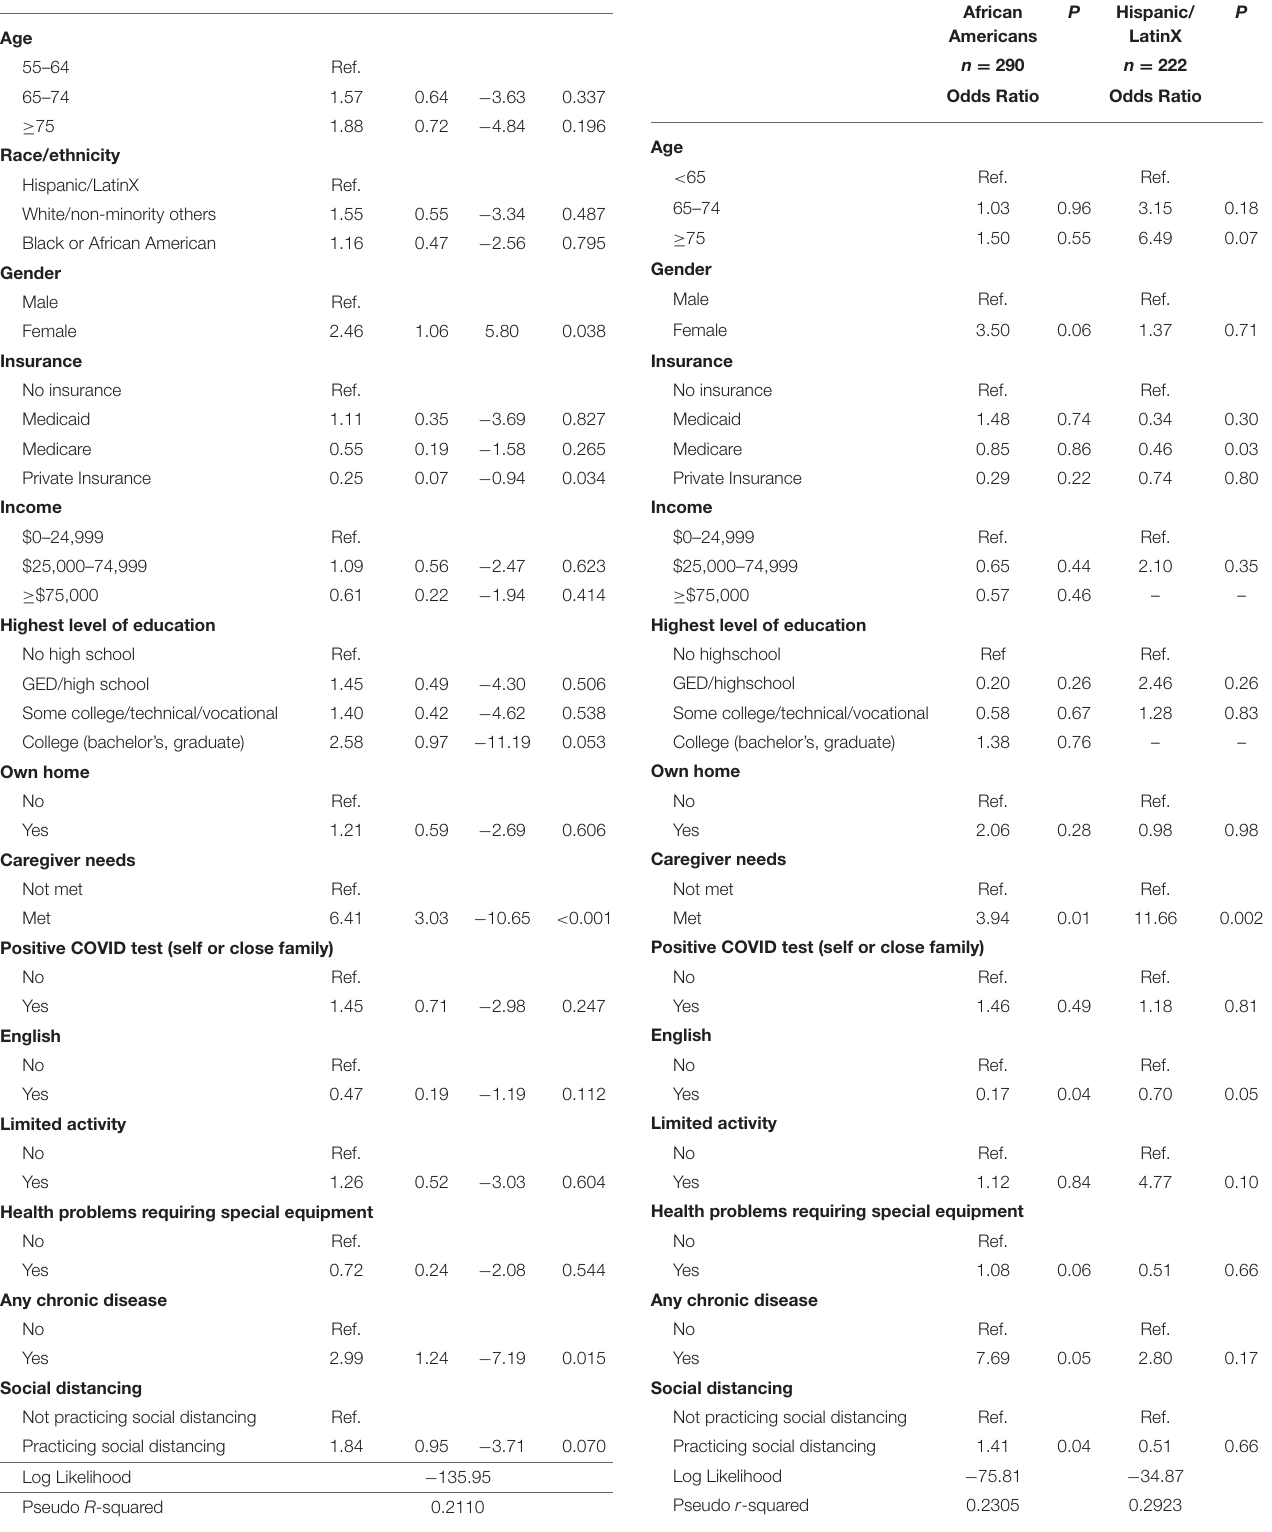
TABLE 3 | Multivariable regression model of the relationship between social isolation and respondent characteristics: correlates of social isolation in African Americans and Hispanic Older